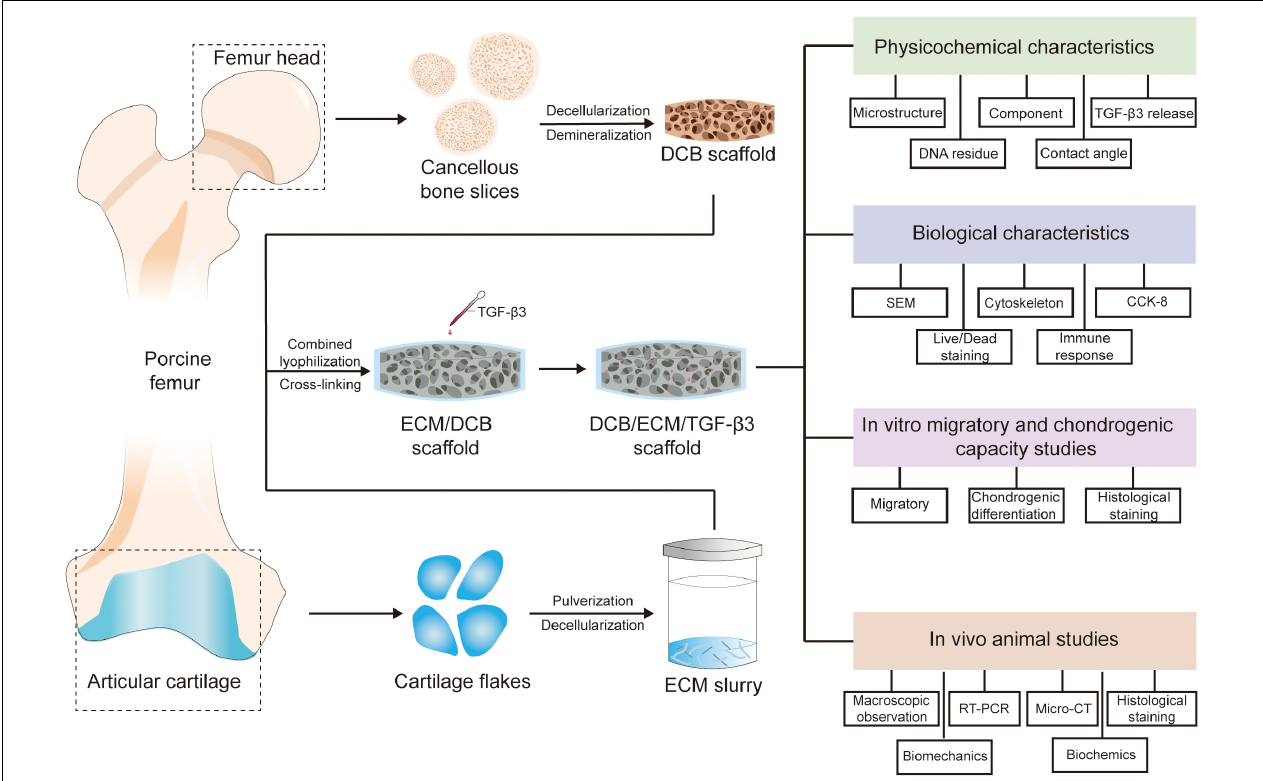
FIGURE 1 | Schematic illustration of the overall study design. DCB, demineralized cancellous bone; ECM, extracellular matrix; TGF- β 3, transforming growth factor- β 3.